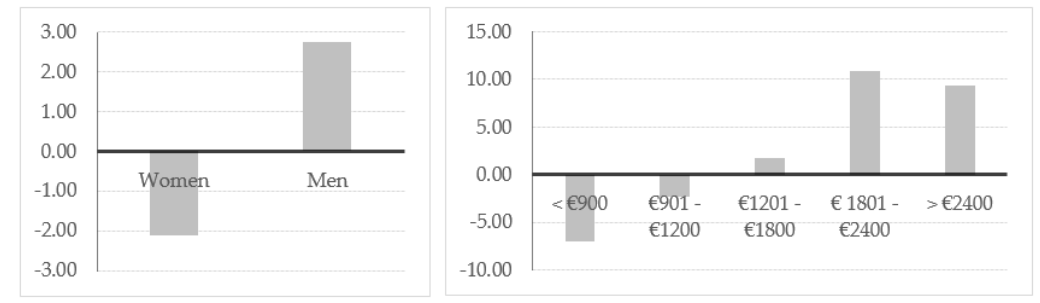
Figure 2. Index of acceptance by gender and income level.